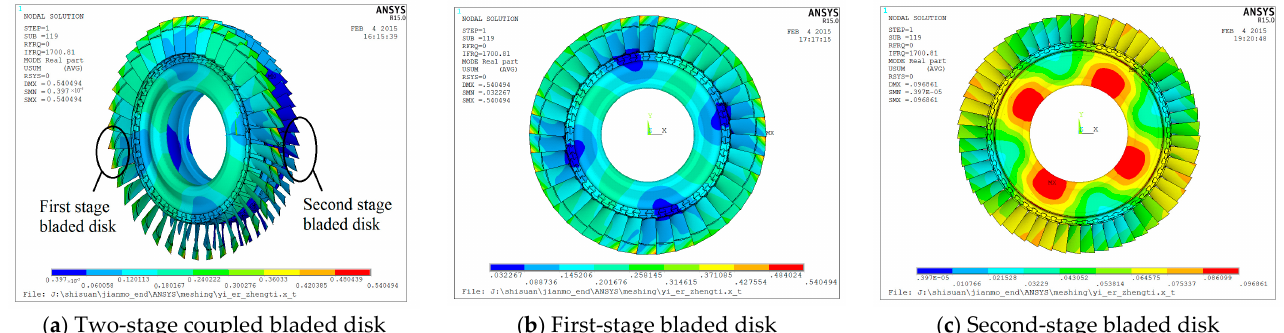
Figure 28. Coupled vibration at a natural frequency of 1700.81 Hz.